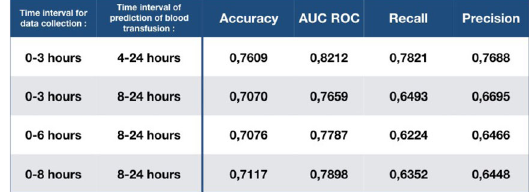
Table 1 (abstract 000055). Voting classifier: integration of logistic regression & random forest